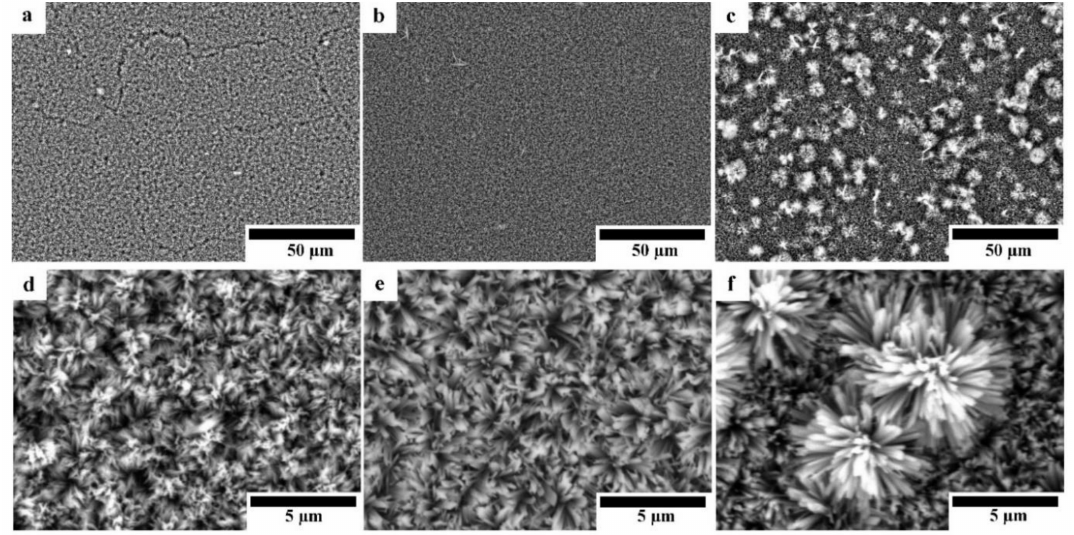
Figure 4. SEM micrographs of HAp-coated samples: ( a , d ) HAp-coated Mg, ( b , e )